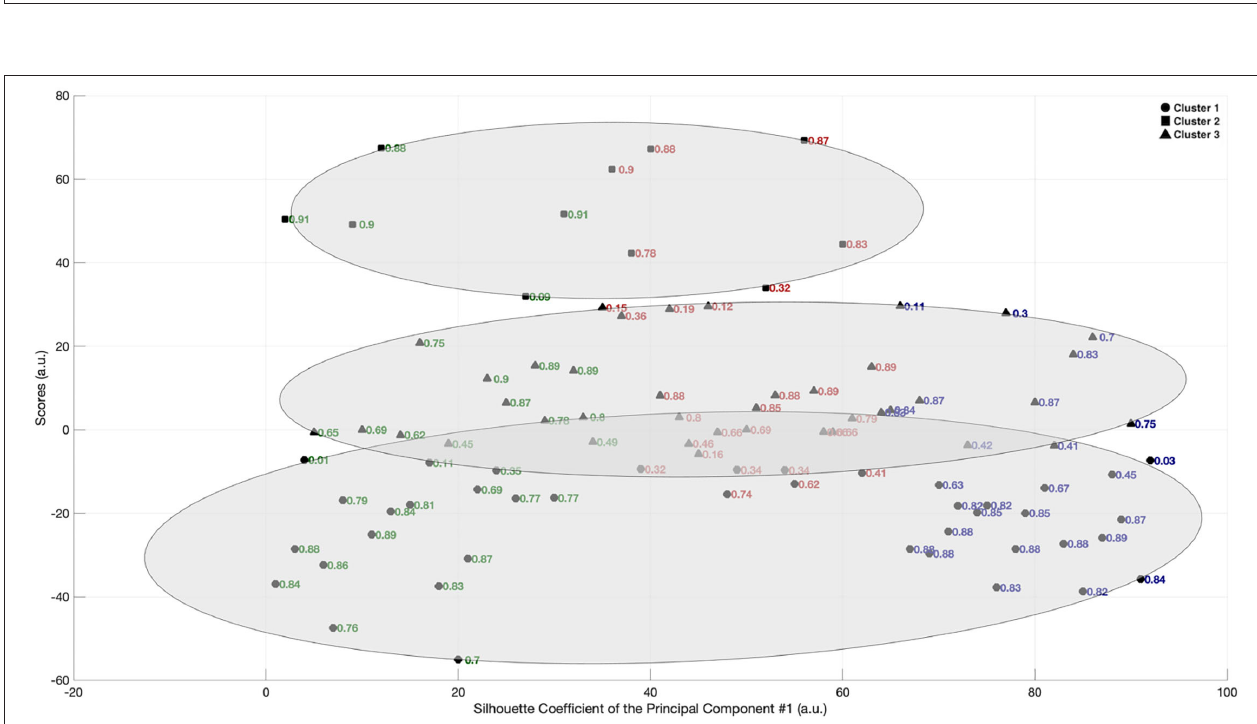
FIGURE 1 | Principal component scores and clustering related to the passing network metrics from Liverpool FC. Manchester FC and Tottenham Hotspur in the 2017/18, 2018/19, and 2019/20 seasons of the UEFA Champions League, coached by Jürgen Klopp, Pep Guardiola and Mauricio Pochettino, respectively.